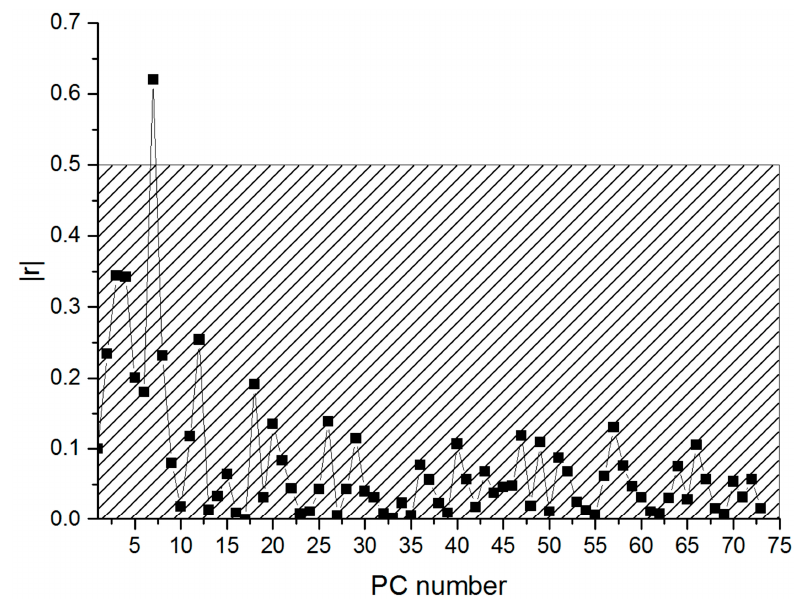
Figure 3. Correlation factor r for various principal